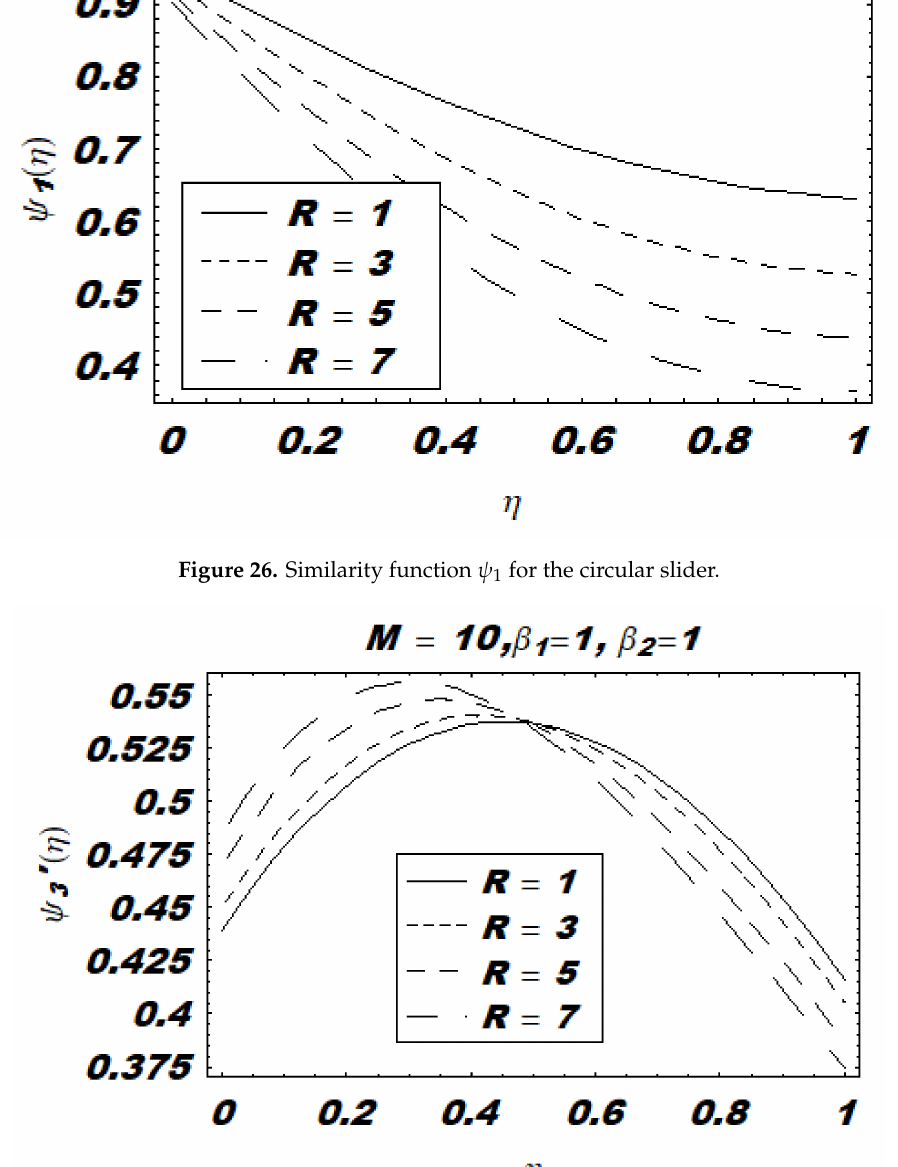
for the circular 3